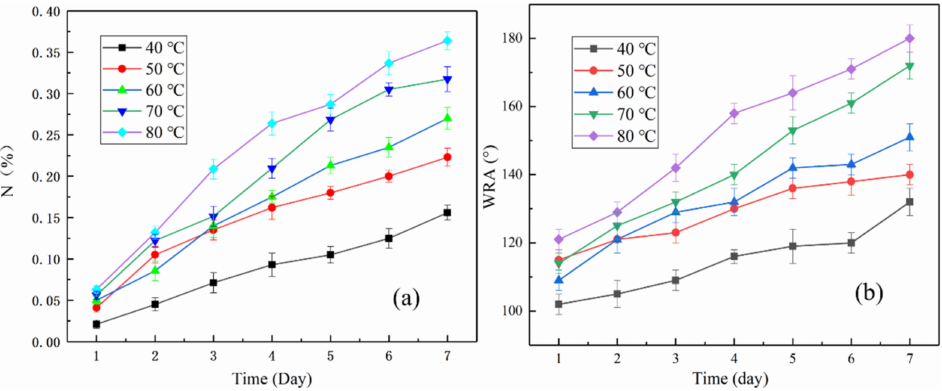
Figure 1. Nitrogen content ( a ) and WRA ( b ) with storage time under different storage